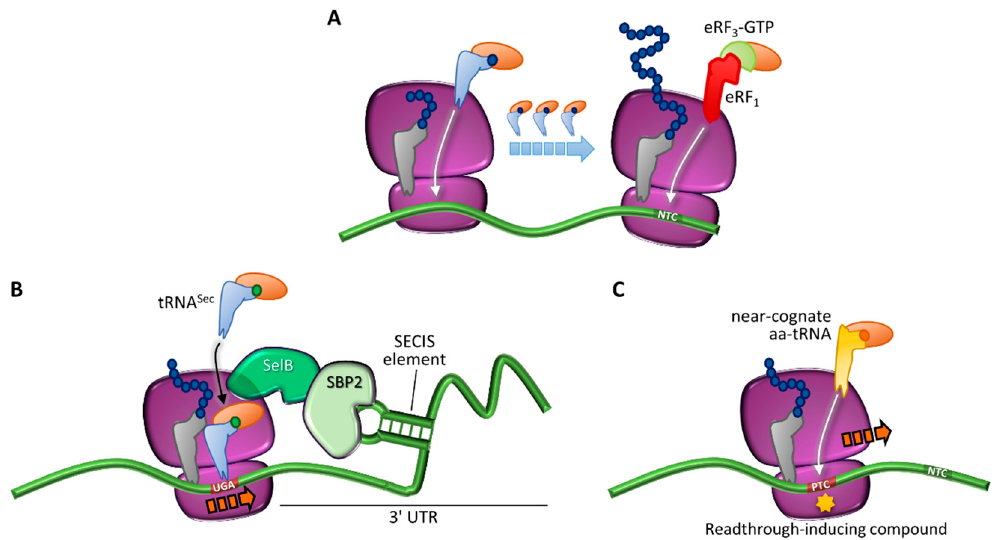
Figure 3. Translation termination and programmed or drug-induced PTC readthrough. ( A ) Translation in normal conditions, driven by incorporation of cognate aa-tRNAs, and termination elicited by eRF 1 and eRF 3 at the natural termination codon (NTC). ( B ) Programmed readthrough, as a result of terminal UGA recoding through incorporation of a selenocysteine-carrying aa-tRNA (tRNA Sec ) mediated by a specialized elongation factor (SelB) and a downstream hairpin structure (selenocysteine inserting sequence, SECIS) recognized by the SECIS-binding protein 2 (SBP2). ( C ) Readthrough-mediated suppression of a PTC through incorporation of a near-cognate aa-tRNA, which can occur spontaneously or be induced by compounds.